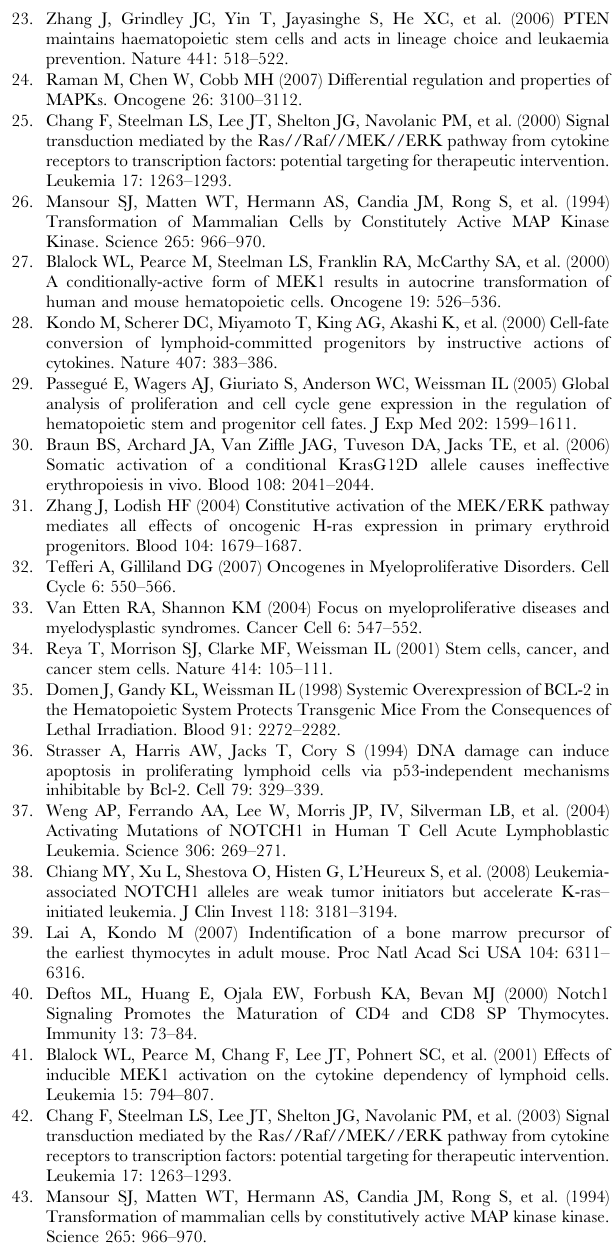
with 1%BSA at 37 u C for 12 hrs, harvested, washed, stained with AnnexinV and 7-AAD, and read on a flow cytometer. Results shown are representative of three independent